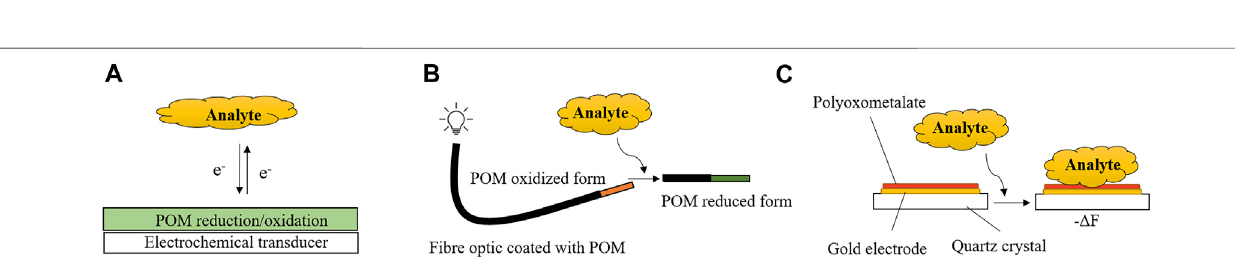
Frontiers in Chemistry |